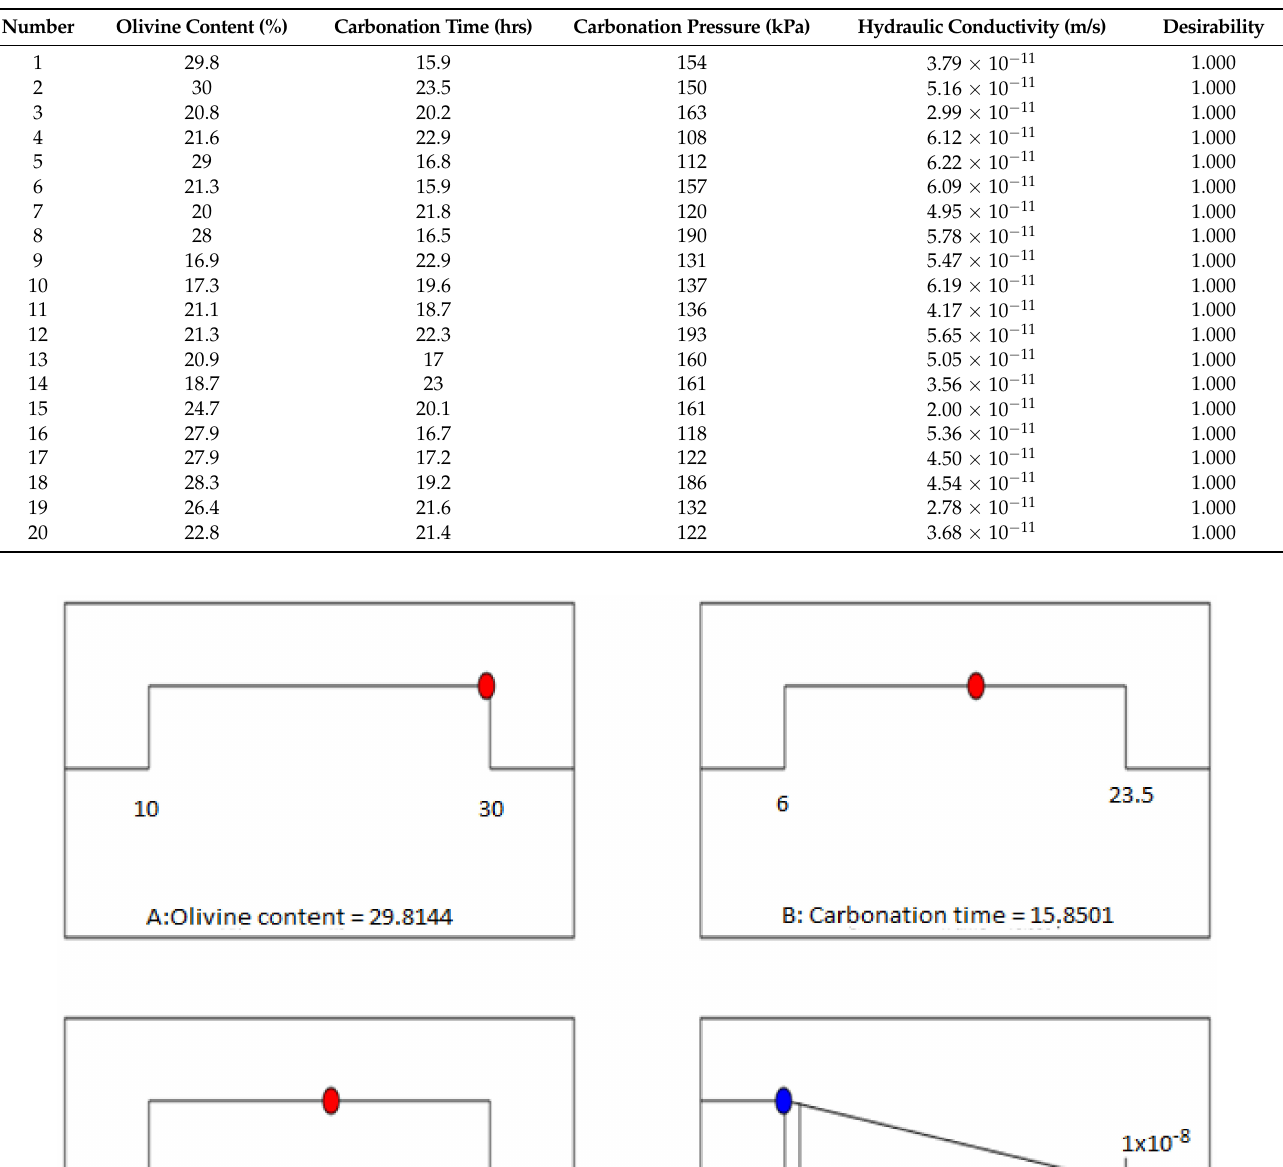
Table 7. Optimized additive ratios and corresponding responses.